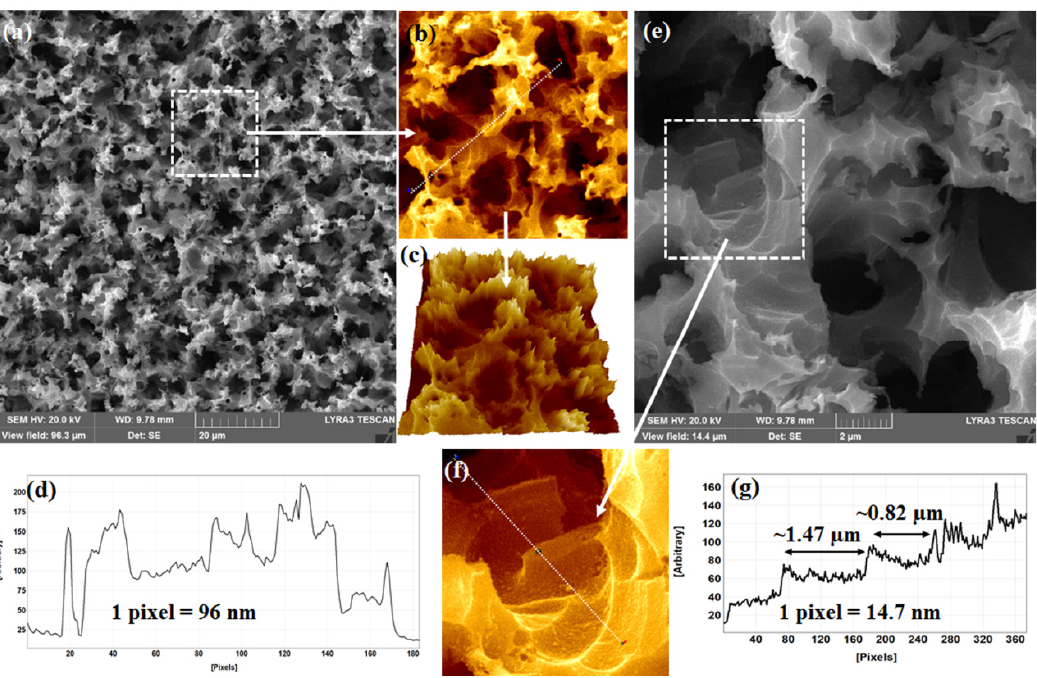
Figure 2. ( a ) FESEM micrograph of Ag-NPs-decorated terraces in Si-NSs, ( b ) Zoom-in view of a small area (20 µm × 20 µm) as marked by the white dotted square in ( a ), ( c ) Hawk-eye view (3D) of the same confirming terraces of various sizes available in Ag-NPs-decorated terraces in Si-NSs, ( d ) Line profile along the white dotted line crossing Ag-NPs-decorated terraces in Si-NSs as shown in ( b ) confirming the hills and valleys that contain different dimensions of terraces, ( e ) High-resolution FESEM micrograph of Ag-NPs-decorated terraces in Si-NSs, ( f ) Zoom-in view of a small area (5 µm × 5 µm) as marked by the white dotted square in ( e ), and ( g ) Line profile along the white dotted line crossing Ag-NPs-decorated terraces in Si-NSs as shown in ( f ) confirming the variation in sizes and shapes of terraces.